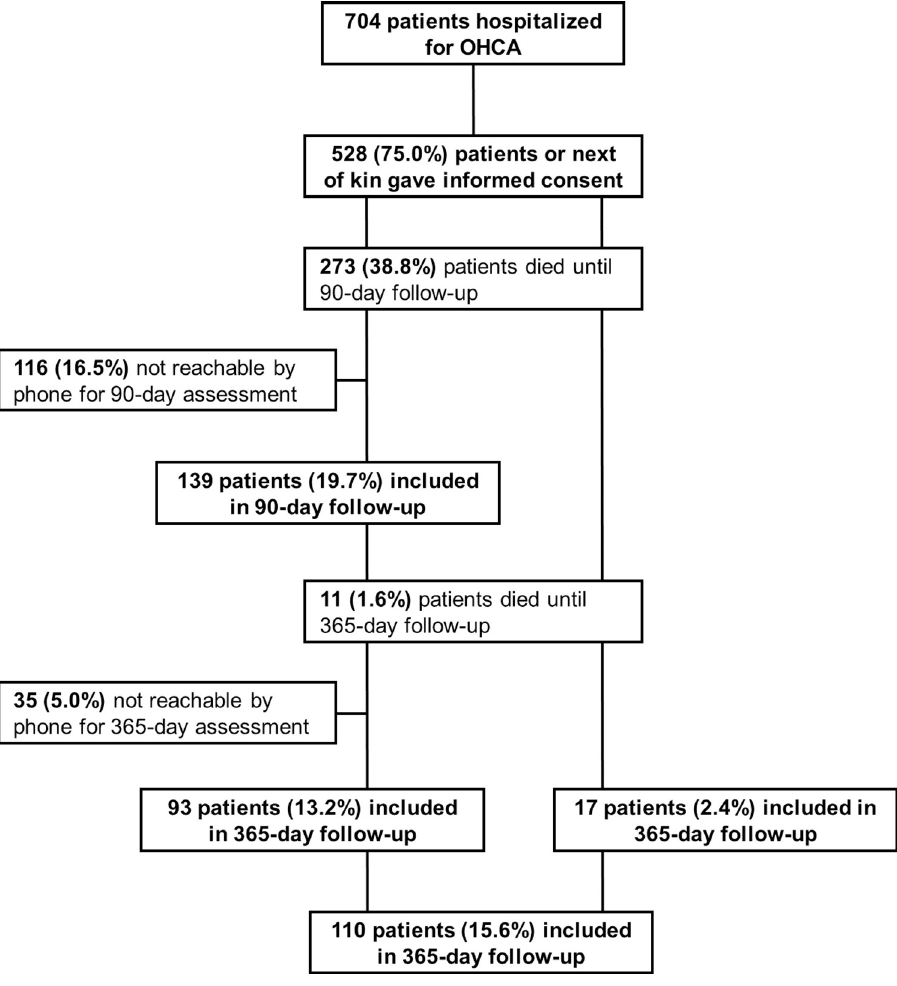
Fig 1. Flow diagram of the study